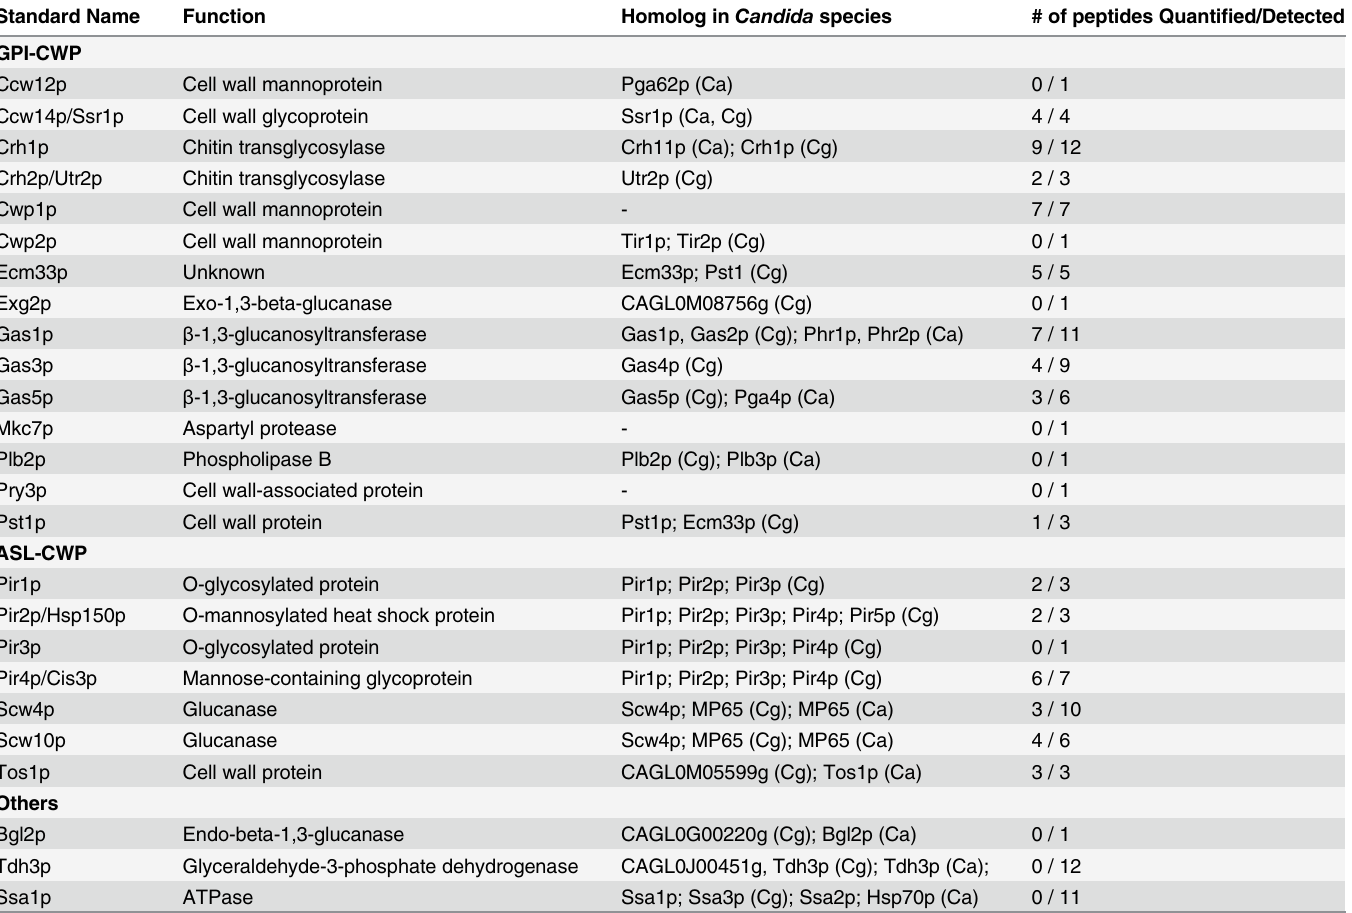
Table 1. There were totally 25 CWPs identified by LC-MS/MS analysis.